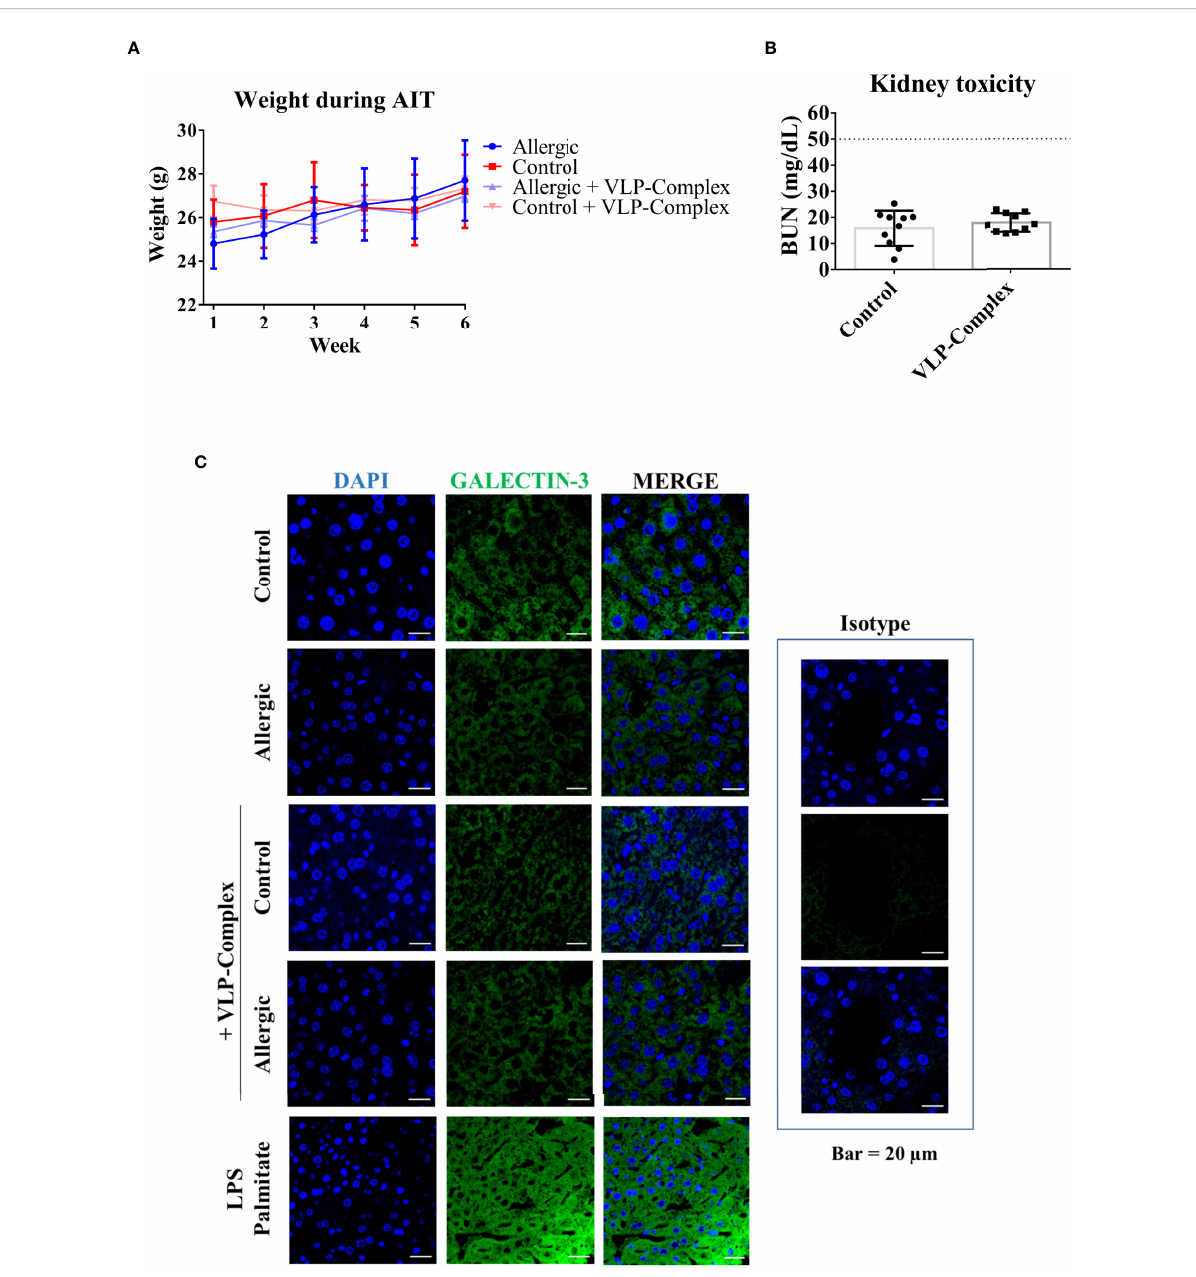
FIGURE 6 In vivo toxicity of VLP-Complex. (A) Weight evolution of mice during the six consecutive weeks receiving VLP-Complex (Allergic n = 4; Allergic + VLP-Complex n = 8; Control n = 4; Control + VLP-Complex n = 10). (B) Determination of blood urea nitrogen levels from Control (n = 10) and VLP-Complex (n = 10) mice. Each mouse was analyzed in triplicates. Data are presented as mean (SD, Mann-Whitney test). (C) Detection of galectin-3 in paraf fi ned livers from Control (n = 3), Allergic (n = 3), Control + VLP-Complex (n = 3) and Allergic + VLP-Complex (n = 3) mice. As a positive control of hepatic stress, livers from control specimens were treated for 72 h with LPS (1 ng/µL) + palmitate (100 ng/µL), following paraf fi nization and immuno fl uorescence as described in Methods . Five images were taken from each mouse. Representative images are shown. Blue: DAPI, green: galectin-3. Bar = 20